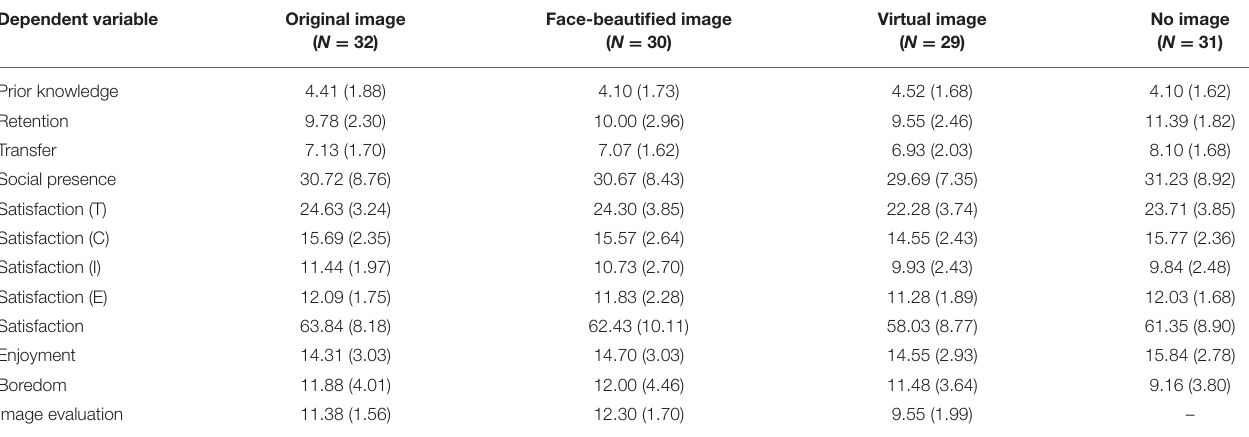
TABLE 1 | Means and standard deviations of all dependent variables for each condition in the image experiment.